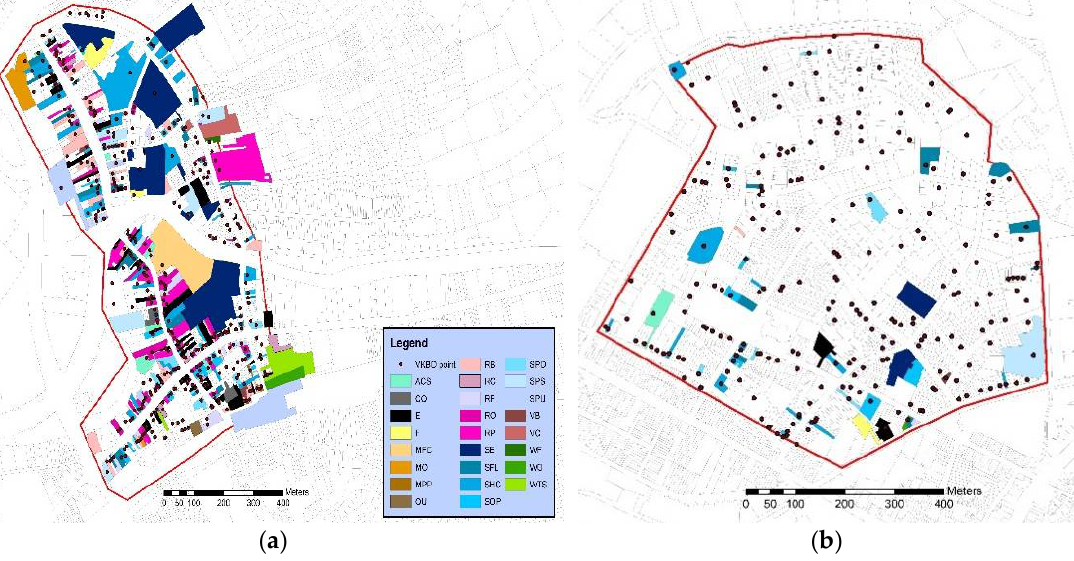
Figure 5. Database address points versus inventory mapping of visual economic activities. ( a ) City center of Deinze; ( b ) Residential area